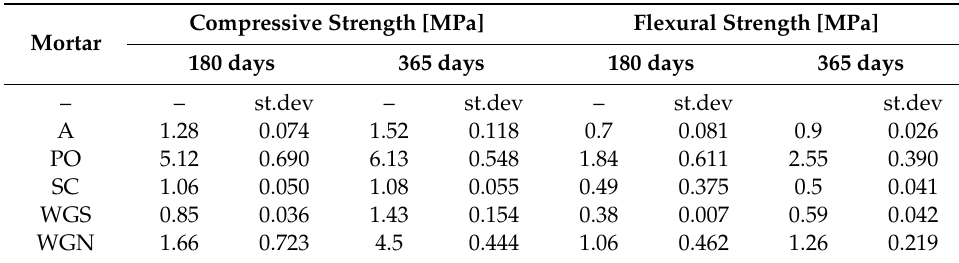
Table 4. Mechanical properties of the